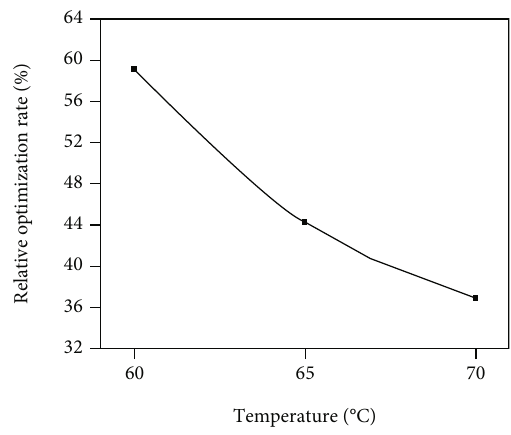
Figure 12: Optimization rate the duration of heat storage of a composite heat storage device under di ff erent heating source